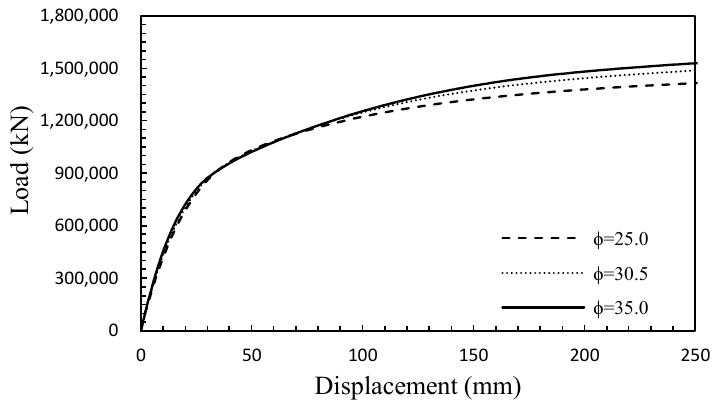
Figure 13. Load–horizontal displacement curve with the internal friction angle of joint.